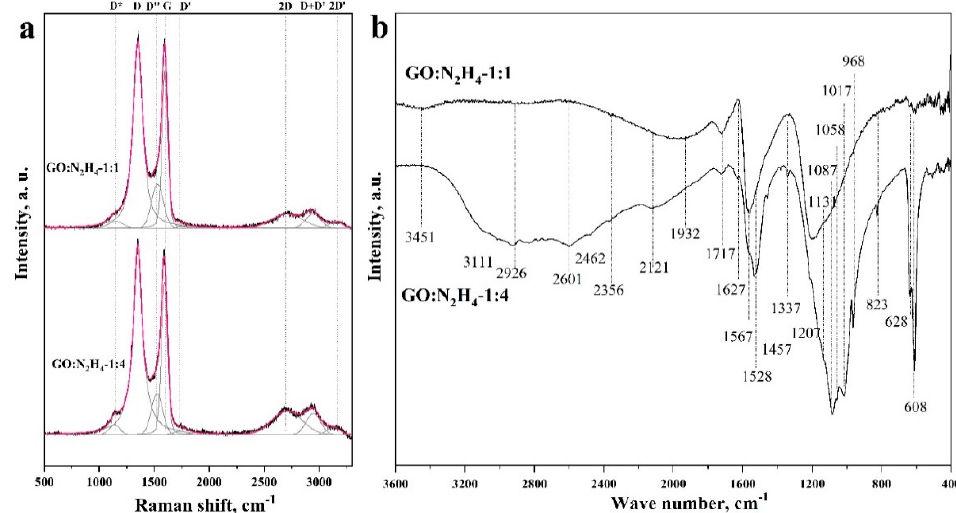
Figure 3. Raman ( a ) and FTIR ( b ) spectra of materials GO:N 2 H 4 –1:1 and GO:N 2 H 4 –1:4.